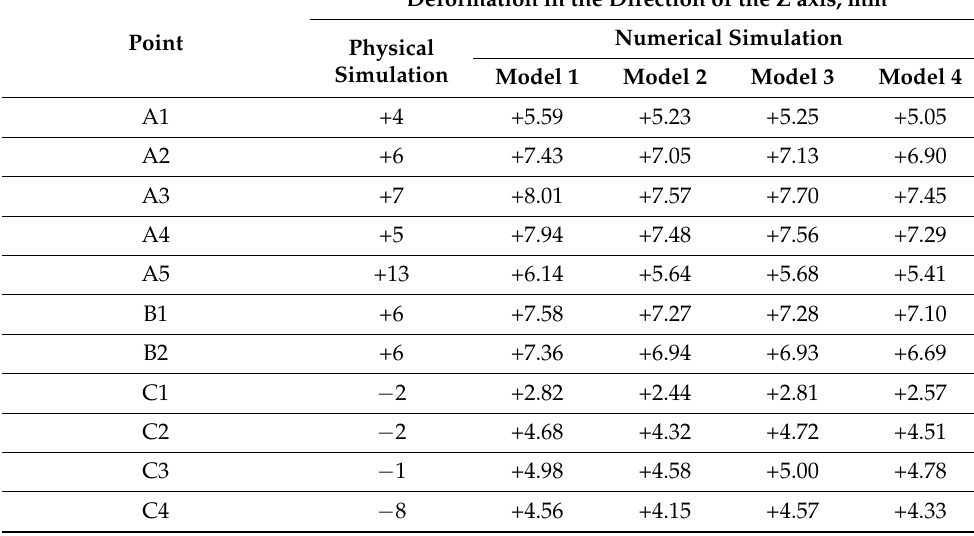
Table 6. Deformations in the Z direction at the measurement points of the furnace wall panel (physical and numerical